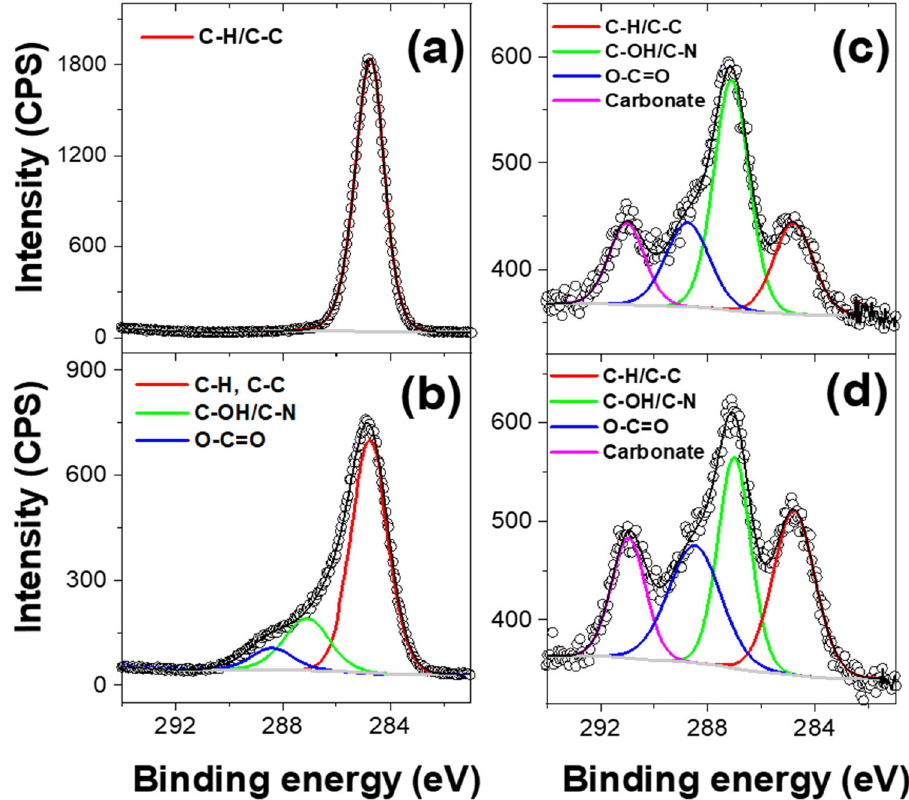
Fig. 6 XPS analysis of the plasma-treated middle ( fi lter) layer. XPS data from un-irradiated ( a ) and irradiated samples after b 1 h, c 2 h and d 3 h. Experimental data (circles) with solid lines from fi t data as indicated. Assignments of surface chemical moieties based on observed chemical shifts are given in the fi